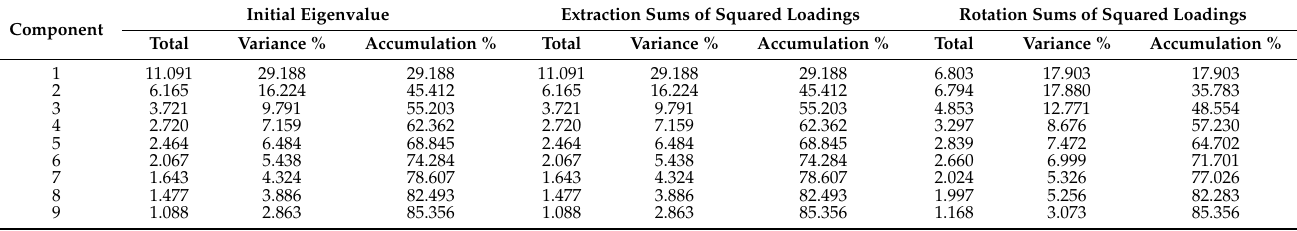
Table 3. Total variance